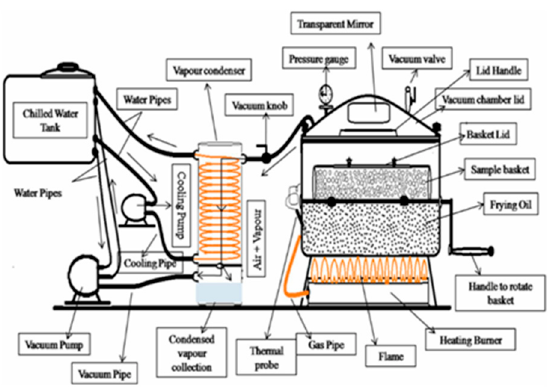
Figure 1. A schematic diagram of the vacuum frying system for industrial production [54].